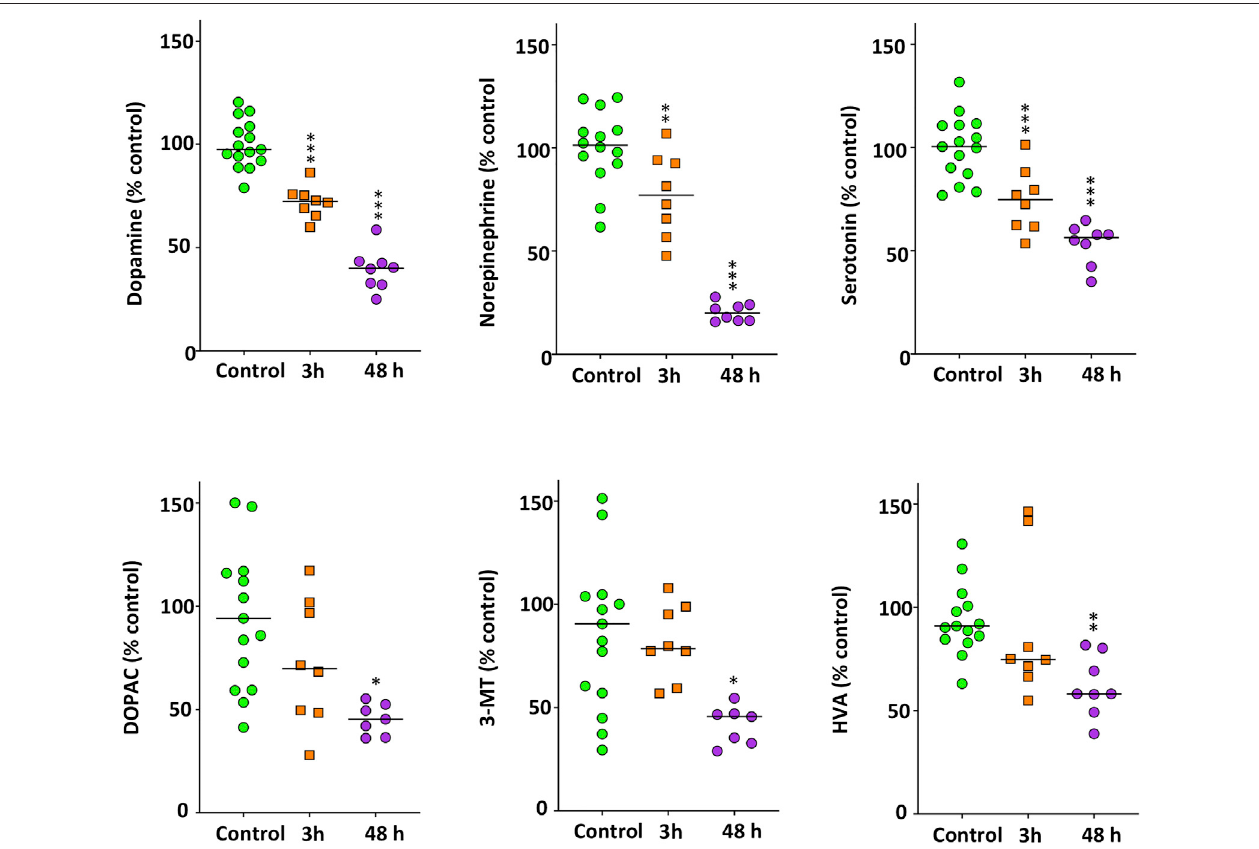
FIGURE 5 | Signi fi cant decrease in the monoaminergic neurotransmitters and other neurochemicals in the brain of zebra fi sh waterborne exposed to 40 mg/L methamphetamine for 3 and 48 h. In each experiment, levels of each neurochemical were normalized to the corresponding control values. For each neurochemical, the combined data is reported as scatter plot with the median ( n (cid:2) 7 – 8 for 3 h exposure and n (cid:2) 15 – 16 for 48 h exposure), * p < 0.05, ** p < 0.01, *** p < 0.001; one-way ANOVAwithDunnett ’ smultiplecomparisontest(dopamine,norepinephrine,serotonin)orKruskalWallistestwithBonferronicorrection(DOPAC,3-MT,HVA).Data from two independent